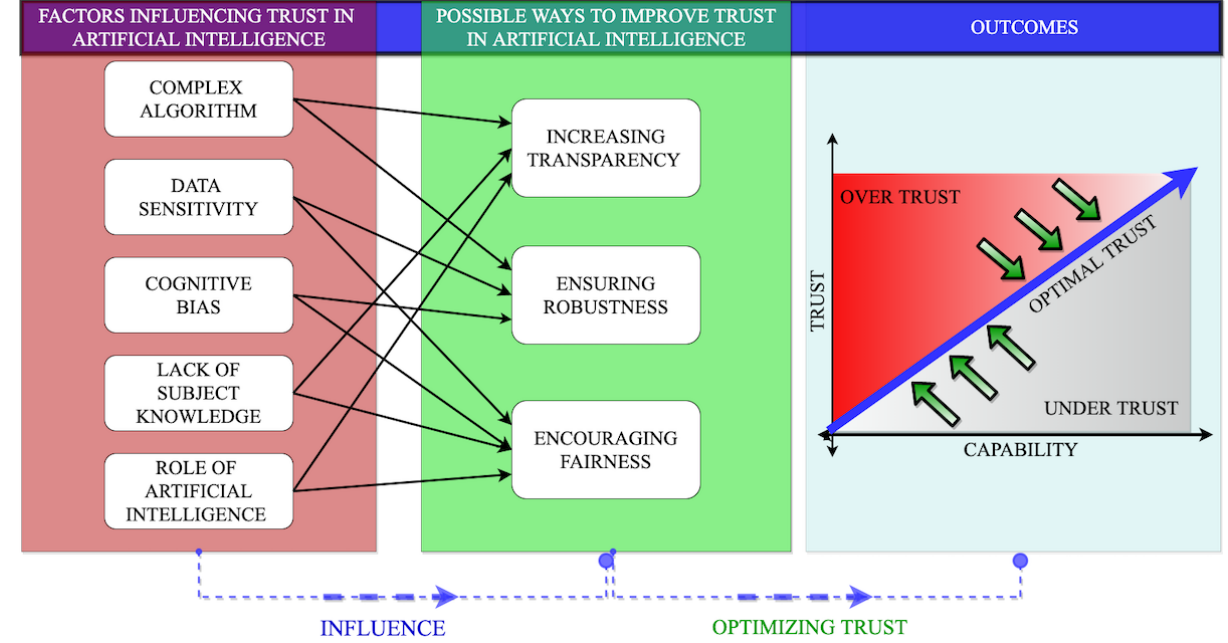
Figure 1. Human factors and trust in artificial